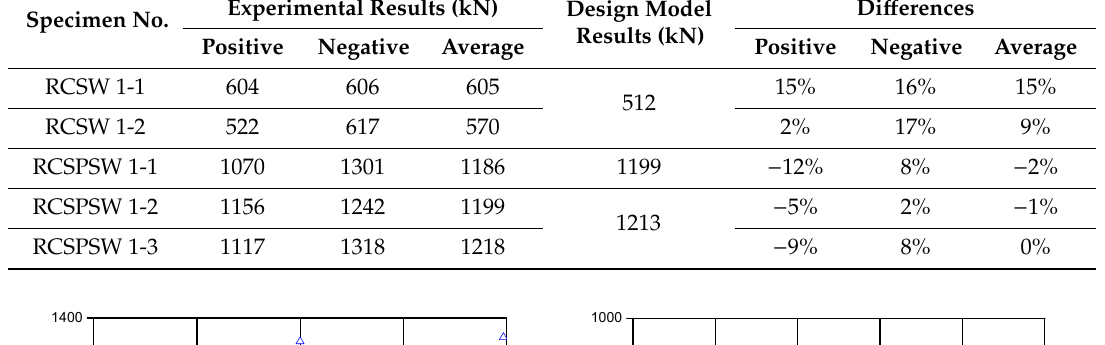
Table 6. Comparisons of Experimental and Design Strength Capacities for Shear Specimens. Specimen No.